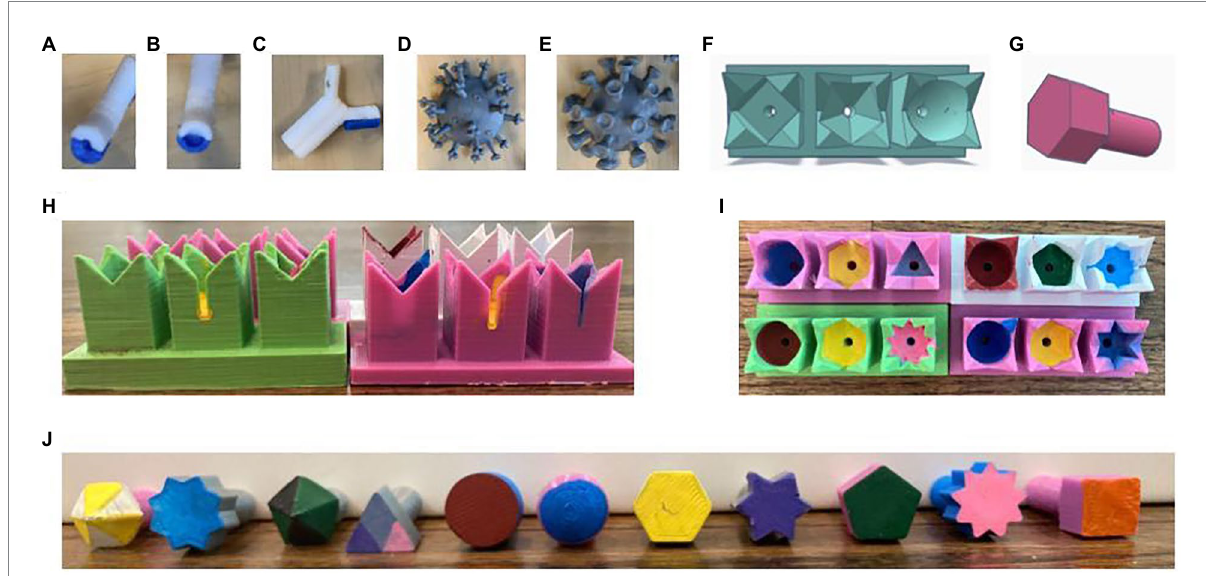
FIGURE 1 Tactile teaching tools. (A , B) Assembled thermoplastic urethane (TPU) antibodies with conical/small binding pockets ( A , Antibody 1) or spherical/ large binding pockets ( B , Antibody 2). (C) Antibody with one detachable light chain removed. (D) Influenza viral particle. (E) SARS-CoV2 viral particle. (F) Tinkercad rendering of an MHC array. (G) Tinkercad rendering of a peptide antigen. (H,I) Front (H) and top (I) views of four different MHC arrays. (J) Front view of all 11 peptide